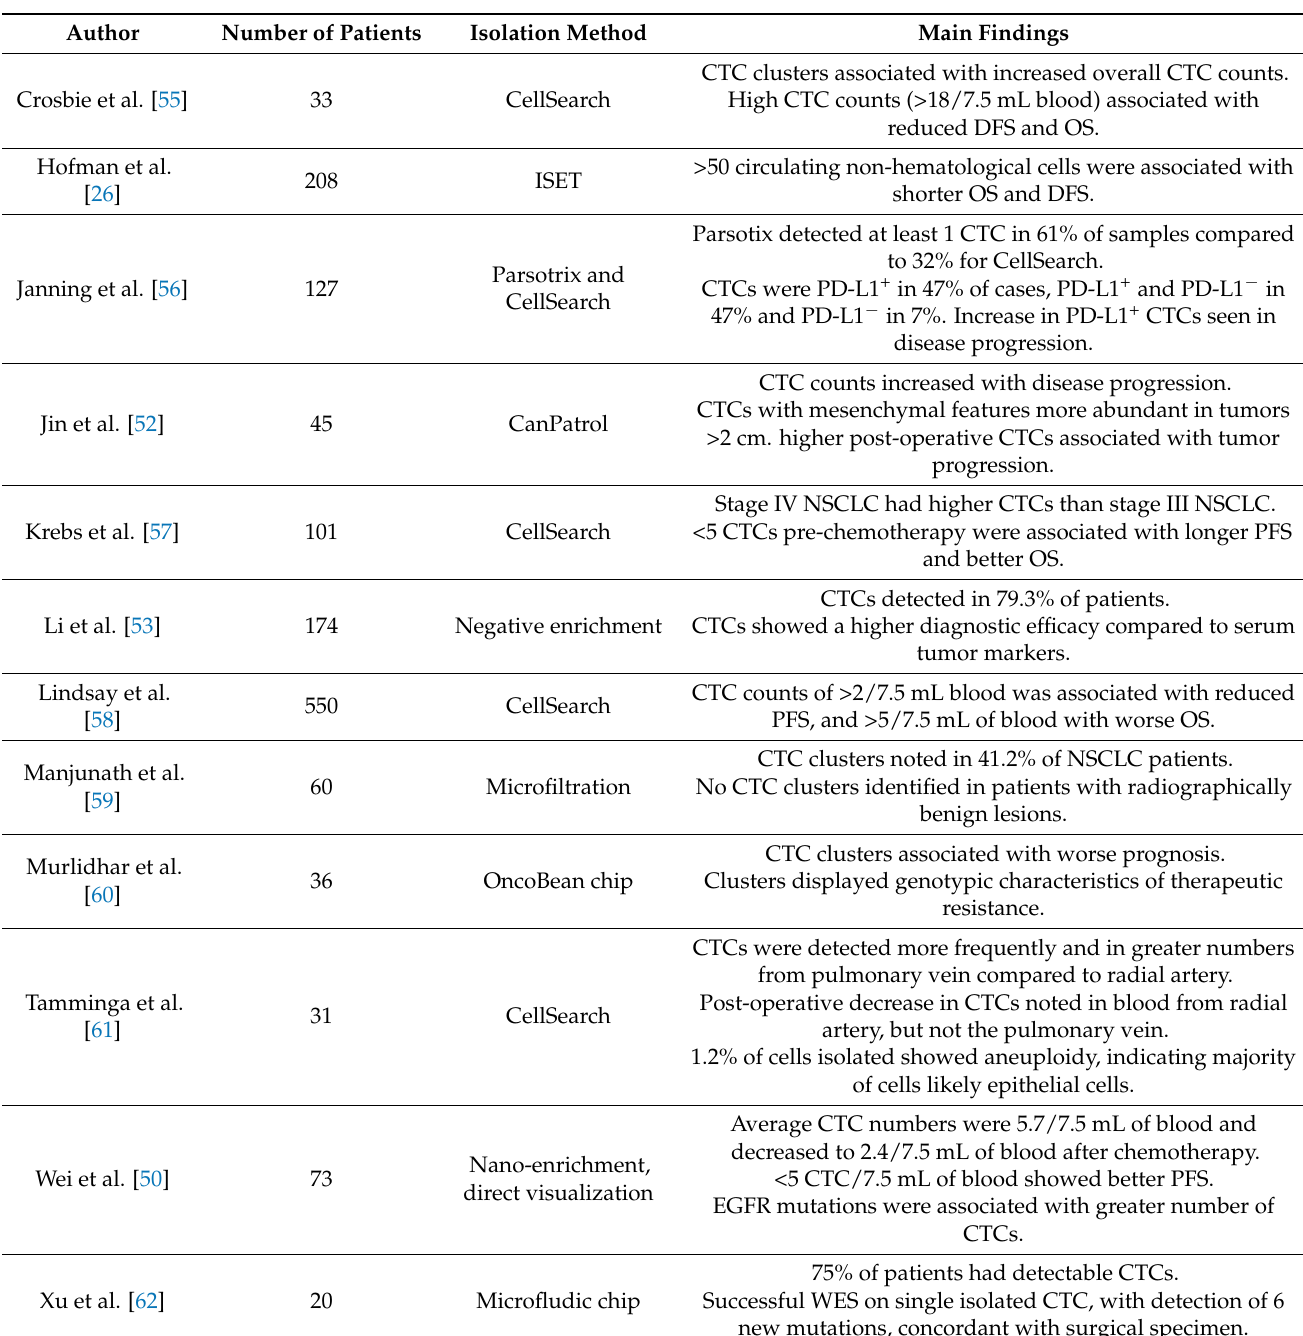
Table 1. Summary of published studies assessing the role of CTCs in lung